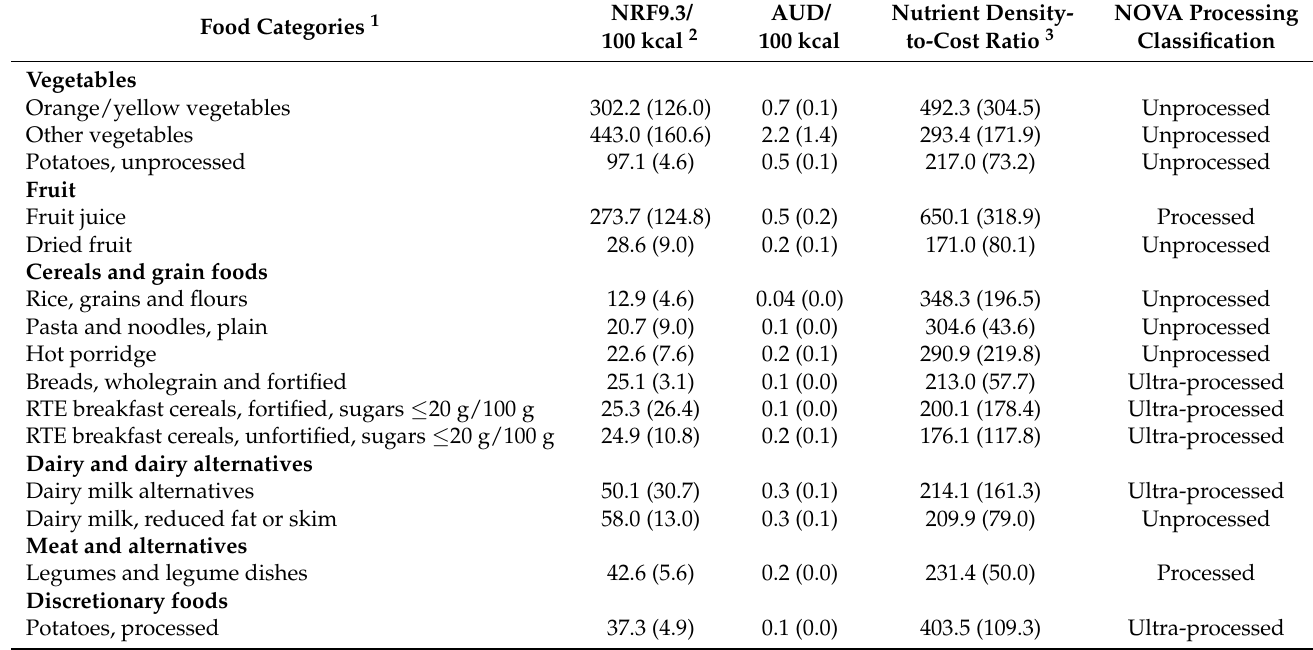
Table 3. Details for the top quartile of nutrient dense, low-cost food categories, including nutrient density/100 kcal, cost/100 kcal, the nutrient density to cost ratio, and NOVA processing classification.